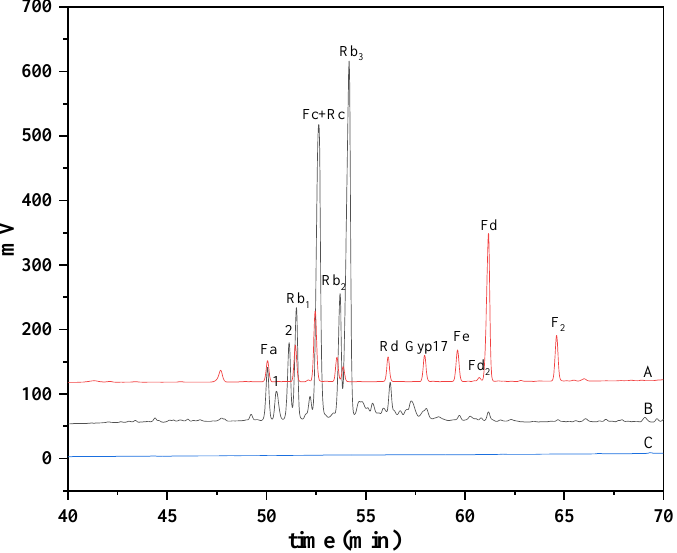
121 Figure 1. HPLC analysis of major saponins in PNF. (A) Commercial standards; (B) PNF extract;